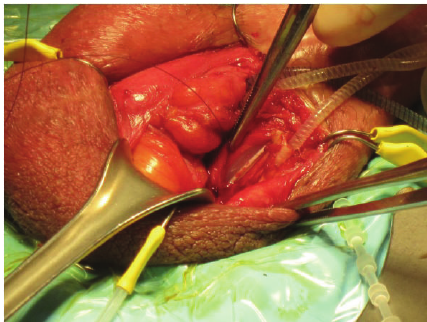
Figure 1: Intraoperative image showing the urethral lesion.